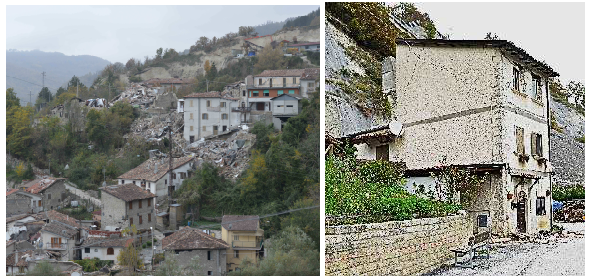
Figure 1. Pescara del Tronto perched village, in Arquata del Tronto, AP, October 2016 (left). The object of focus: a stand- alone damaged building